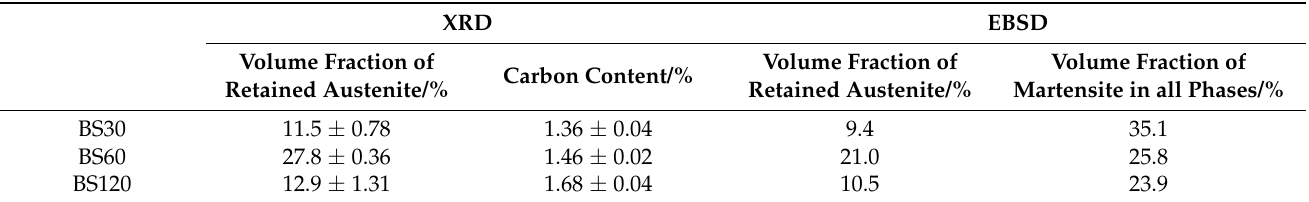
Figure 5. XRD patterns of the three samples before ( a ) and after deformation ( b ). Table 2. Volume fraction and carbon content of retained austenite measured by XRD and EBSD, and the volume fraction of martensite of the undeformed samples measured by EBSD.